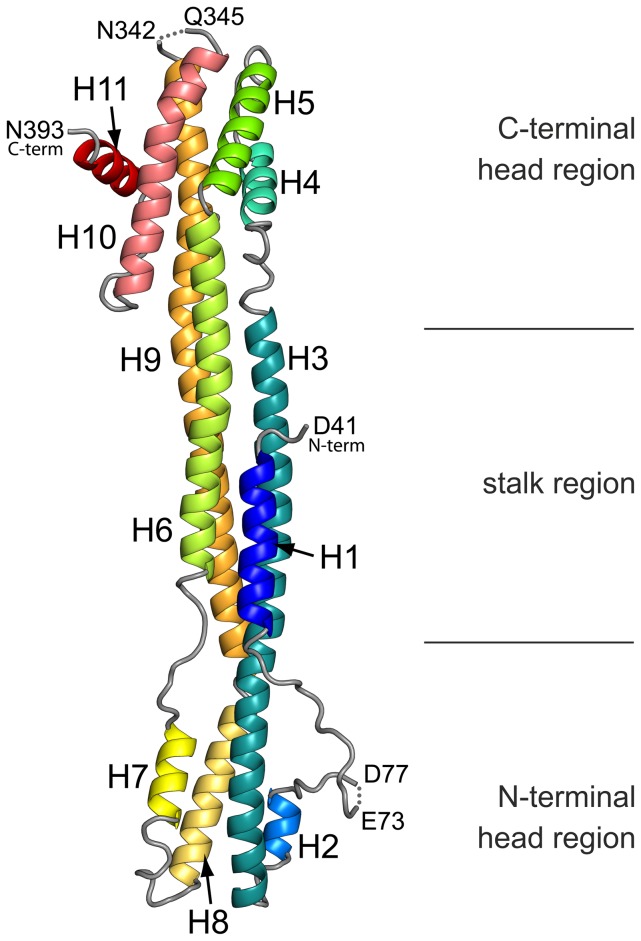
Structure of IE1CORE.Ribbon representation of the rhIE1 monomer (residues 41–393) illustrating the elongated, femur-like fold of IE1. The eleven α-helices (H1 to H11) are colored from blue to red. The location of the two head regions and the central stalk are indicated by black lines.